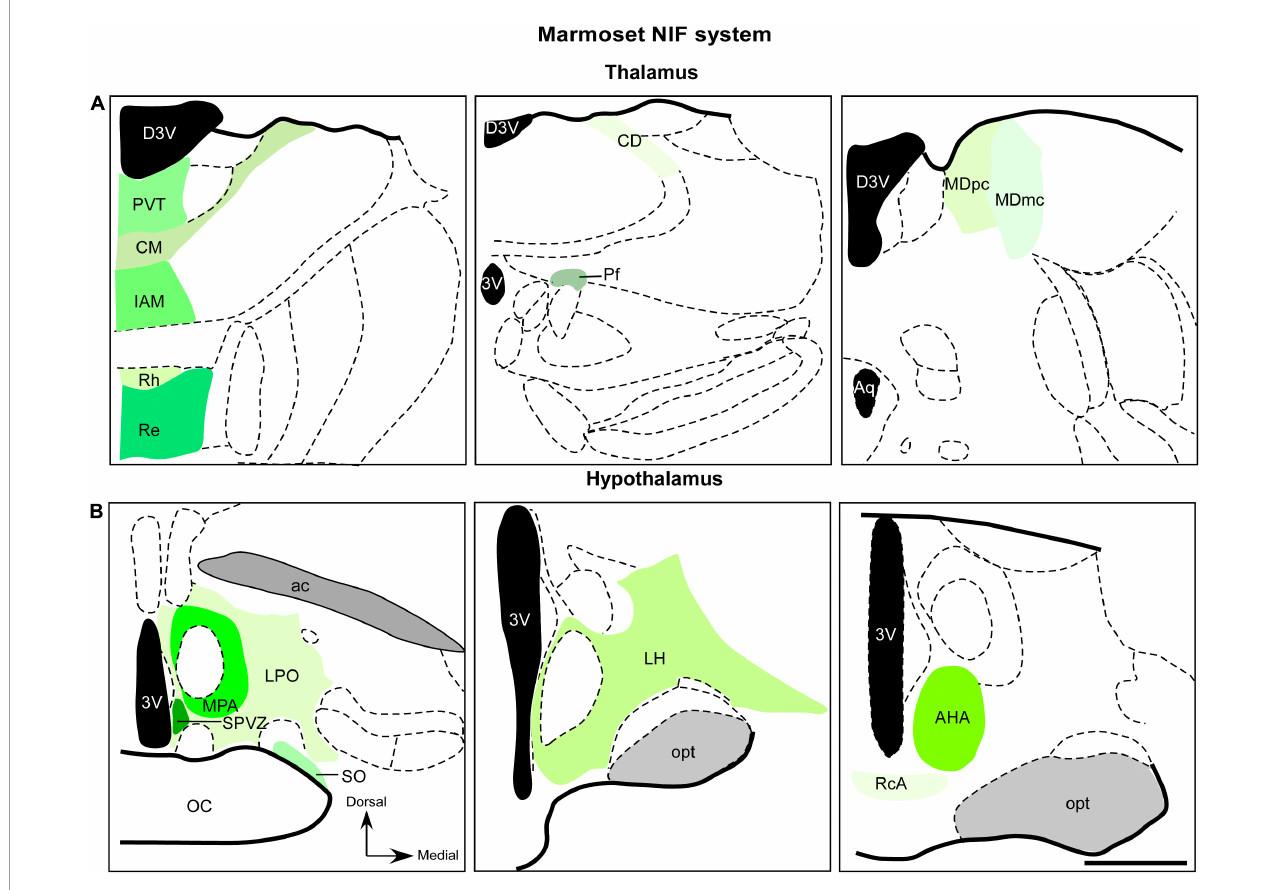
FIGURE3 Diagrammatic representation of diencephalic marmoset non-image-foming nuclei (green). Retinal projections were described in mediodorsal nucleus, midline and intralaminar thalamic structures (A) and hypothalamic domains (B) . The RGCs subtypes that project to these regions have not yet been elucidated. 3v, third ventricle; ac, anterior commissure; AHA, anterior hypothalamic area; aq, cerebral aqueduct; CD, central dorsal nucleus; CM, central medial nucleus; D3v, dorsal 3v; Iam, inter-antero medial nucleus; LH, lateral hypothalamic area; LPO, lateral preoptic area; MDmc, magnocellular division of mediodorsal nucleus; MDpc, parvocellular division of mediodorsal nucleus; MPA, medial preoptic area; opt, optic tract; Pf, parafascicular nucleus; PvT, paraventricular thalamic nucleus; RcA, retrochiasmatic area; Re, reuniens nucleus; Rh, rhomboid nucleus; SO, supraoptic nucleus; SPVZ; sub paraventricular zone. Scale bar: 500 µ m. Adapted from Paxinos et al.